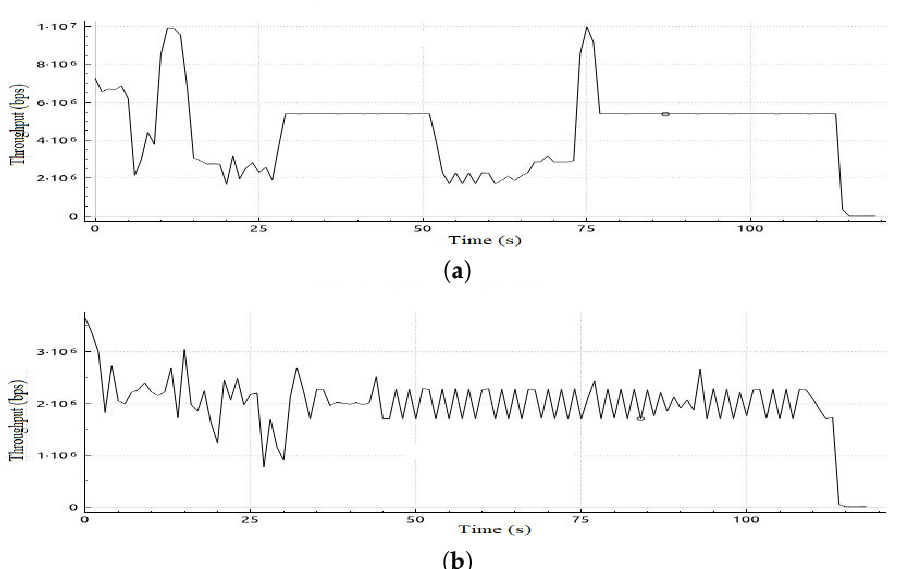
Figure 14. Throughput obtained in Scenario 3 in case of applying and without applying proposed adaptive QoS model for 120-seconds VoIP traffic flow, ( a ) Throughput obtained in Scenario 3 in case of applying proposed model, ( b ) Throughput obtained in Scenario 3 without applying proposed adaptive QoS model.